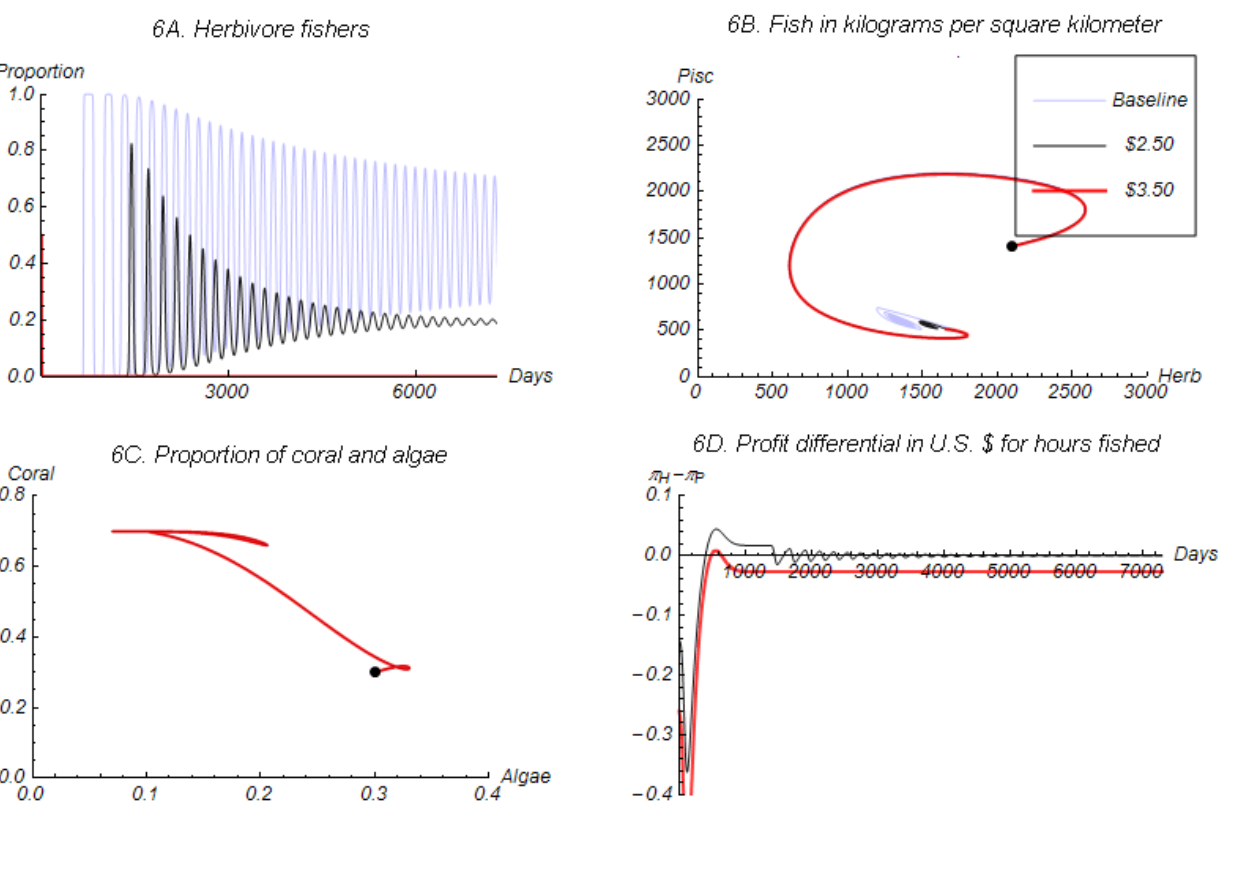
Fig. 6 . Simulation results reflecting changes in the price of piscivorous fish showing time-series plots for fishers (6A) and profit differentials (6D), and parametric plots for fish (6B) and for coral and algae (6C). The dots represent initial